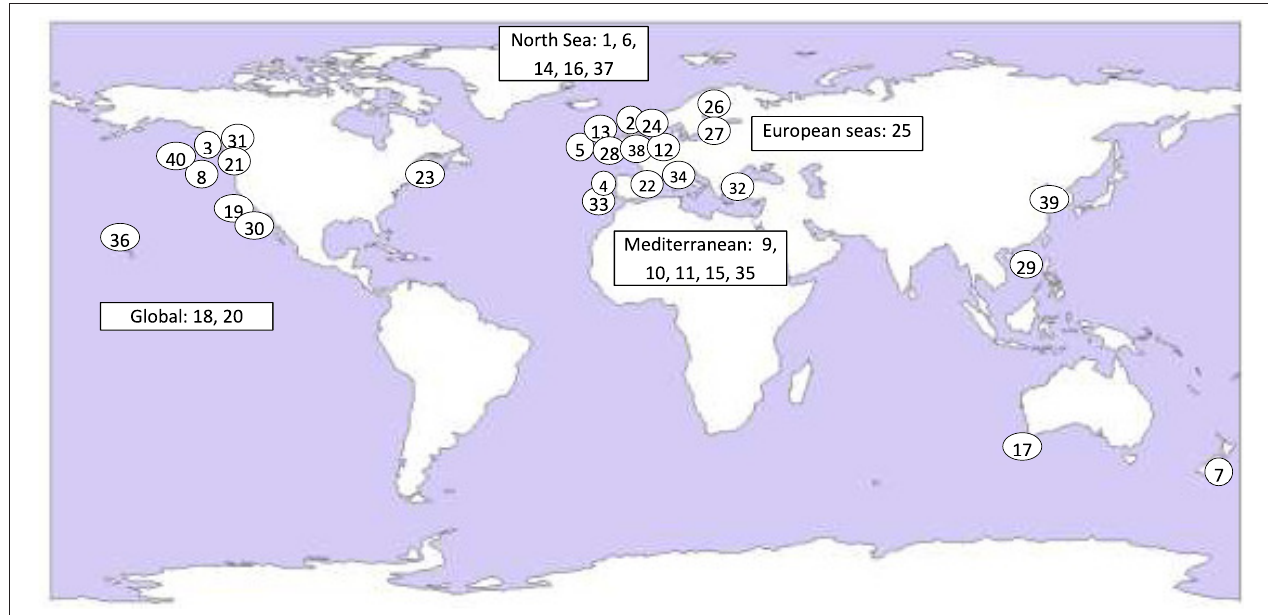
FIGURE 1 | Map with studies included in this review. Global studies and sea areas with several studies are shown in separate text boxes. Key: 1, Eastern North Sea ( Andersen and Stock, 2013); 2, U.K. (Aubry and Elliott, 2006); 3, Canada’s Pacific (Ban et al., 2010); 4, Portugal (Batista et al., 2014); 5, NE Atlantic (Benn et al., 2010); 6, North Sea (Certain et al., 2015); 7, New Zealand (Clark et al., 2016); 8, Canada’s Pacific (Clarke Murray et al., 2015); 9, Mediterranean Sea (Claudet and Fraschetti, 2010 ); 10, Mediterranean Sea (Coll et al., 2012); 11, Mediterranean Sea (Coll et al., 2016); 12, Netherlands (de Vries et al., 2011); 13, UK (Eastwood et al.,